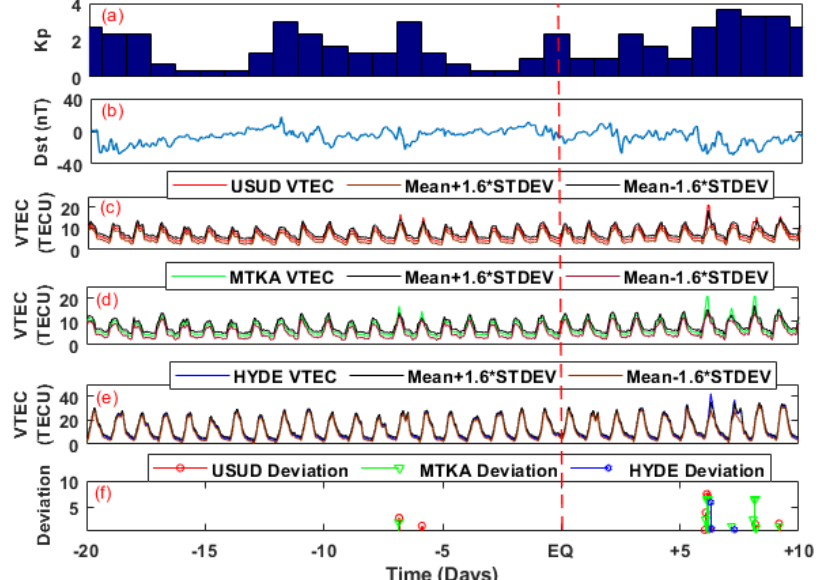
Figure 10. The solar and geomagnetic storm indices ( a ) Kp and ( b ) Dst of Japan earthquake, ( c ) Statistical analysis of USUD (IGS station Japan) VTEC with IQR bounds, ( d ) Analysis of MTKA (IGS station Japan) VTEC with pre-de fi ned IQR bounds, ( e ) Time series analysis of HYDE (IGS station India) VTEC with IQR bounds, ( f ) Deviation of time series statistical analysis of VTEC for all available stations (USUD, MTKA, and HYDE). The red dashed line shows the earthquake day. The * is for multiplication.